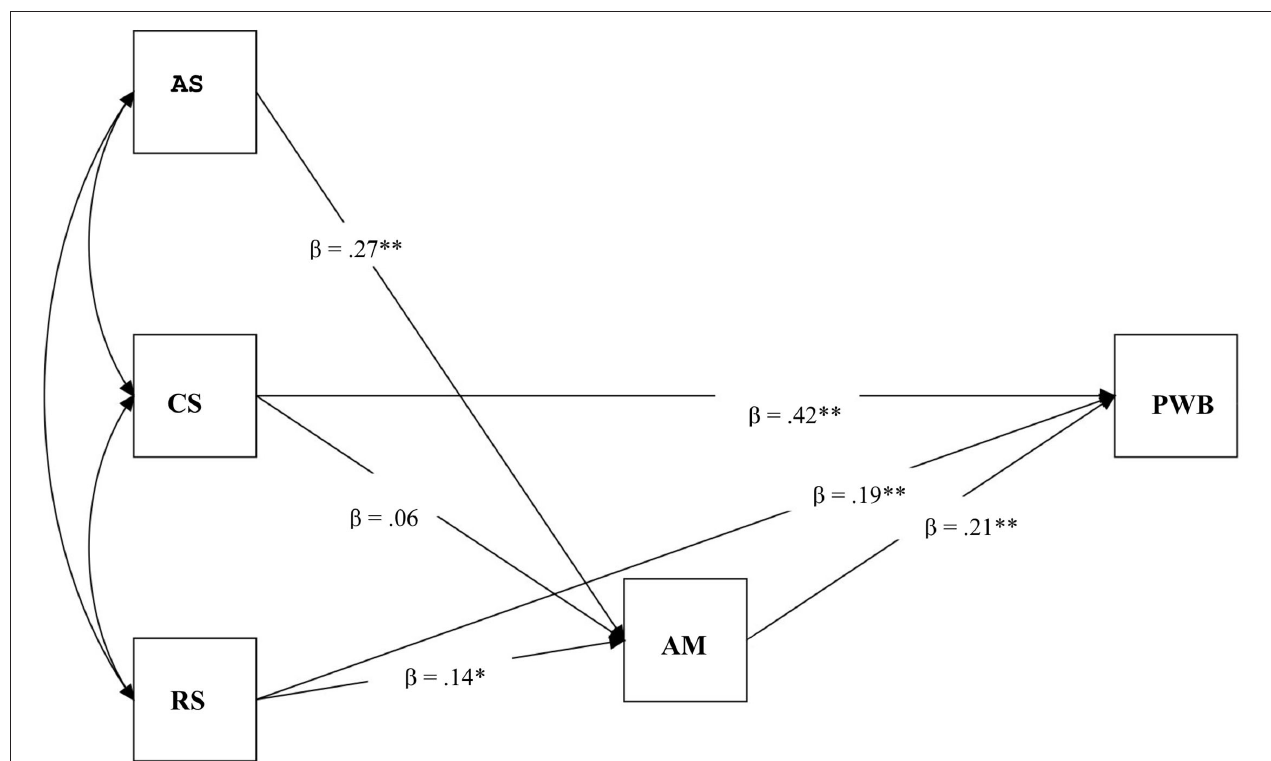
FIGURE 2 | The path between needs satisfaction, motivation and PWB for the elderly Chinese. X 2 /df = 2.222, p = 0.014, RMSEA = 0.049, CFI = 0.979, TLI = 0.946, SRMR = 0.015. AS, autonomy satisfaction; CS, competence satisfaction; RS, relatedness satisfaction; AM, autonomous motivation; PWB, psychological well-being. * p < 0.05, ** p <